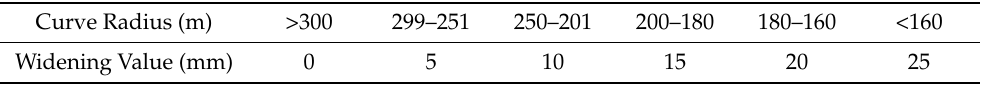
Table 8. Gage widening values in East German railways